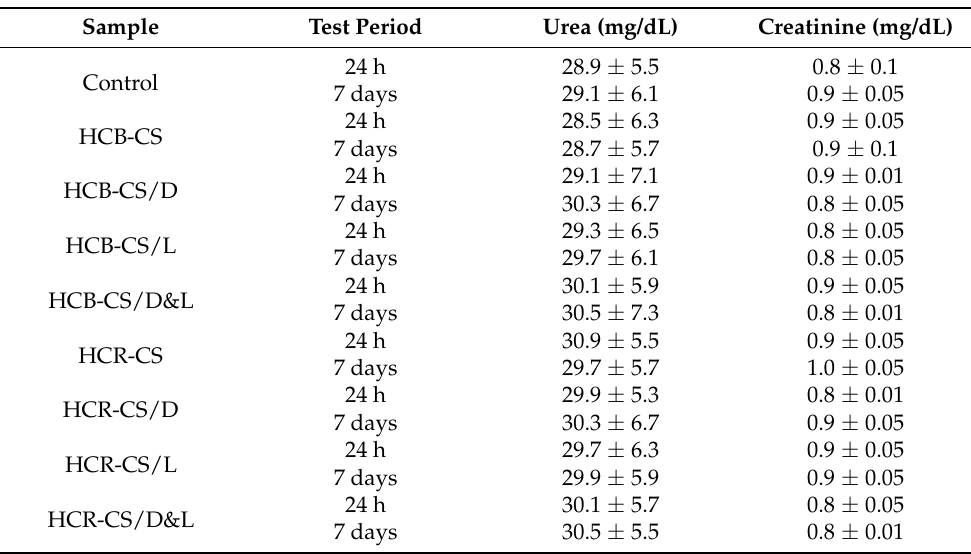
Table 7. Changes in blood levels of urea and creatinine in animals that received electrospun samples. Values are expressed as arithmetic mean ± SD of the average of urea and creatinine levels for 5 mice per